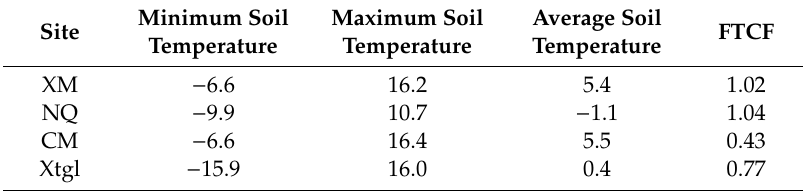
Figure 4. Distribution of plant growth-promoting rhizobacteria at different sites, BRA is Bradyrhizobium , MES is Mesorhizobium , BAC is Bacillus , and PSE is Pseudomonas . Table 4. Soil temperature information and the freezing – thawing cycle frequency at each site. Table 4. Soil temperature information and the freezing–thawing cycle frequency at each site.